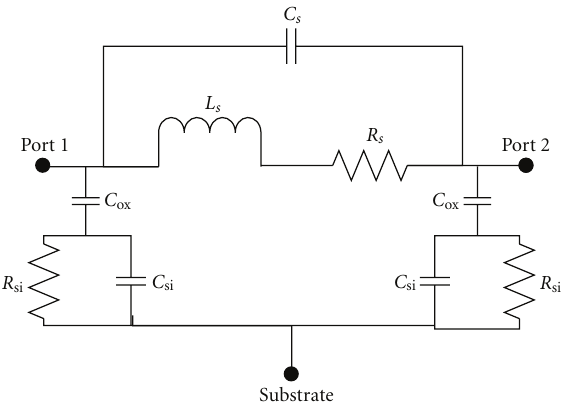
Figure 2: π -type electrical model of a single-layer, spiral